Question: What does this figure show? Answer in one sentence.
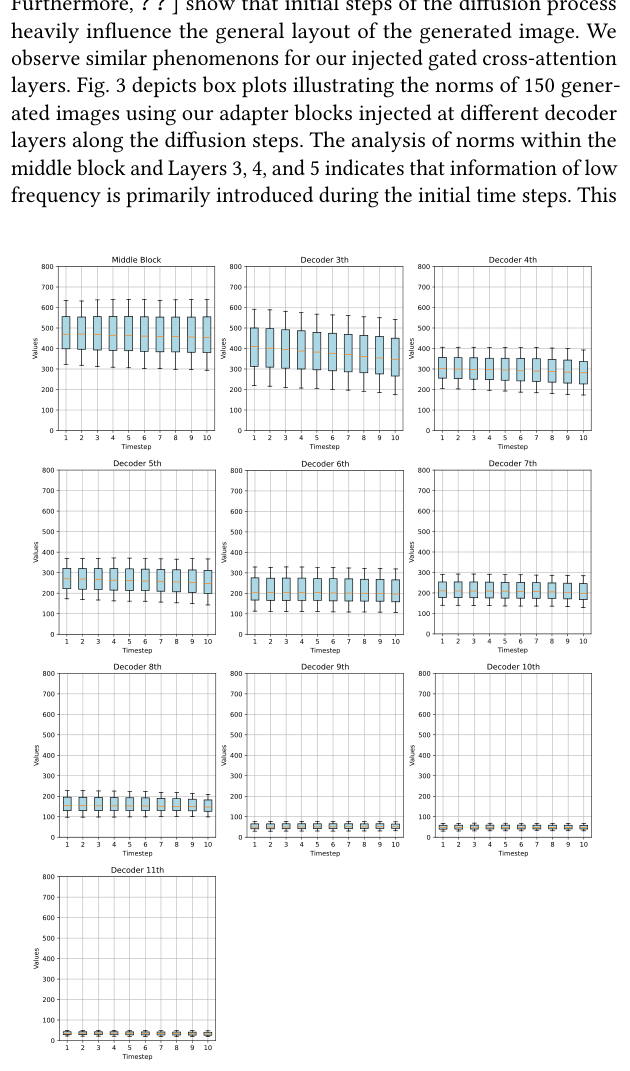
Answer: Norms of gated cross attention outputs across UNet layers. Plots reveals the introduction of low-frequency information in early layers at the initial time steps where as high-frequency details are encoded in higher layers.